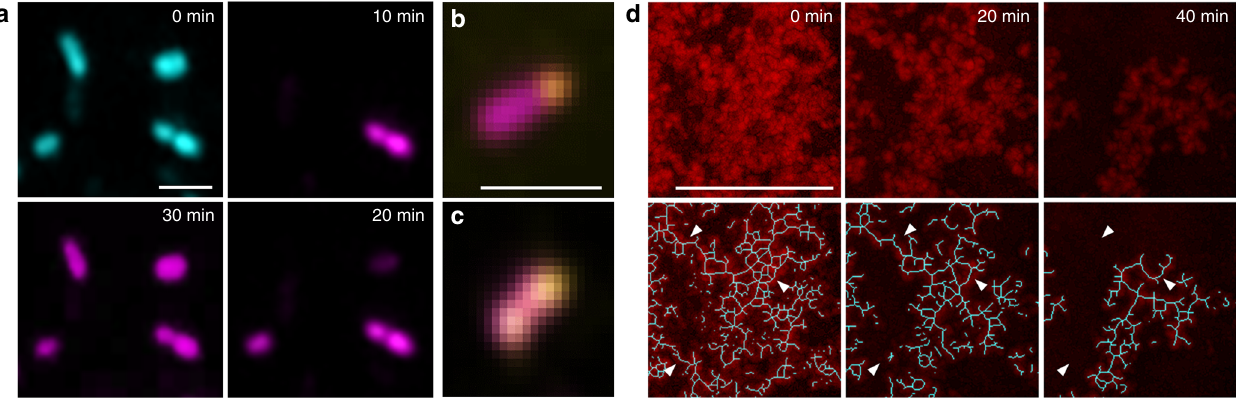
Fig. 2 Time-lapsed bacterial killing and glucan degradation by ferumoxytol-activated H 2 O 2 . a Bacterial cells are labelled in blue by SYTO 60 and dead cells in purple by propidium iodide ( n = 4). High-magni fi cation close-up views of ( b , c ) single bacterial cell showing nanoparticles (labelled with Alexa Fluor 488, in yellow; upper/lower panels) bound to its surface (Scale bar: 1 µ m). d Time-lapsed EPS glucans (labelled in red with Alexa Fluor 647-dextran conjugate) degradation by ferumoxytol-mediated H 2 O 2 catalysis ( n = 4) (Scale bar: 100 µ m) system for targeting the acidic bio fi lm microenvironment. To to H 2 O 2 at a concentration of 1%, under acidic (4.5) or near assess the bioactivity of ferumoxytol-mediated H 2 O 2 catalysis, we neutral pH (6.5) conditions. To visually observe the distribution of viable and dead bacteria, intact S. mutans cells were labelled conducted high-resolution time-lapsed imaging using fl uores- with SYTO 60 and propidium iodide (PI) was used to determine cently labelled bacterial cells ( Streptococcus mutans ) and insoluble α -glucans (Fig. 2). Ferumoxytol (1 mg ml − 1 ) was added to an bacterial killing over time at the single-cell level. The fl uorescence images show that S. mutans viability was affected as early as actively growing bacterial cells suspension followed by exposure NATURE COMMUNICATIONS| (2018) 9:2920 |DOI: